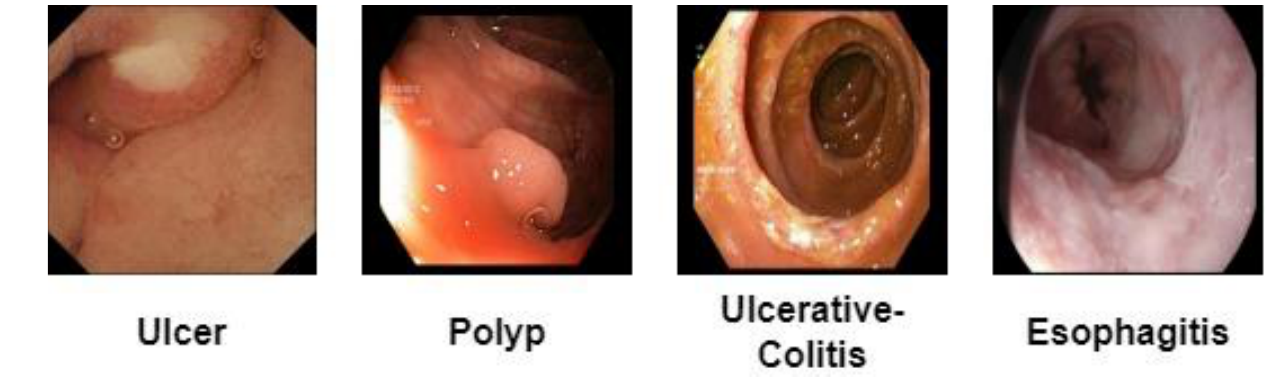
Figure 1. Proposed methodology.